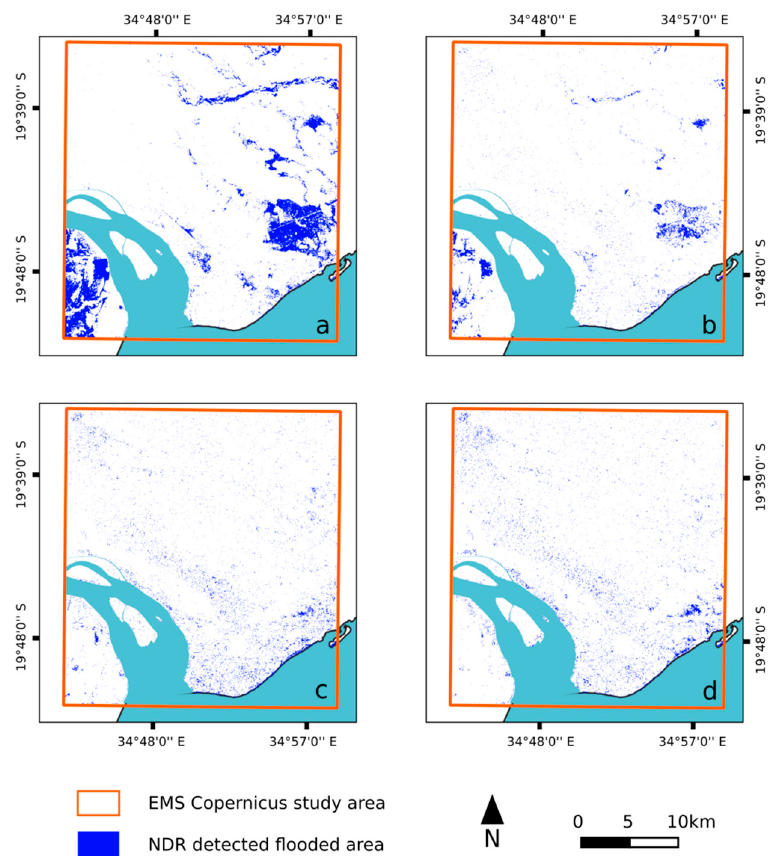
Figure 13. Map of flood extent in Beira area between 20 March 2019 and 7 April 2019. ( a ) 20 March